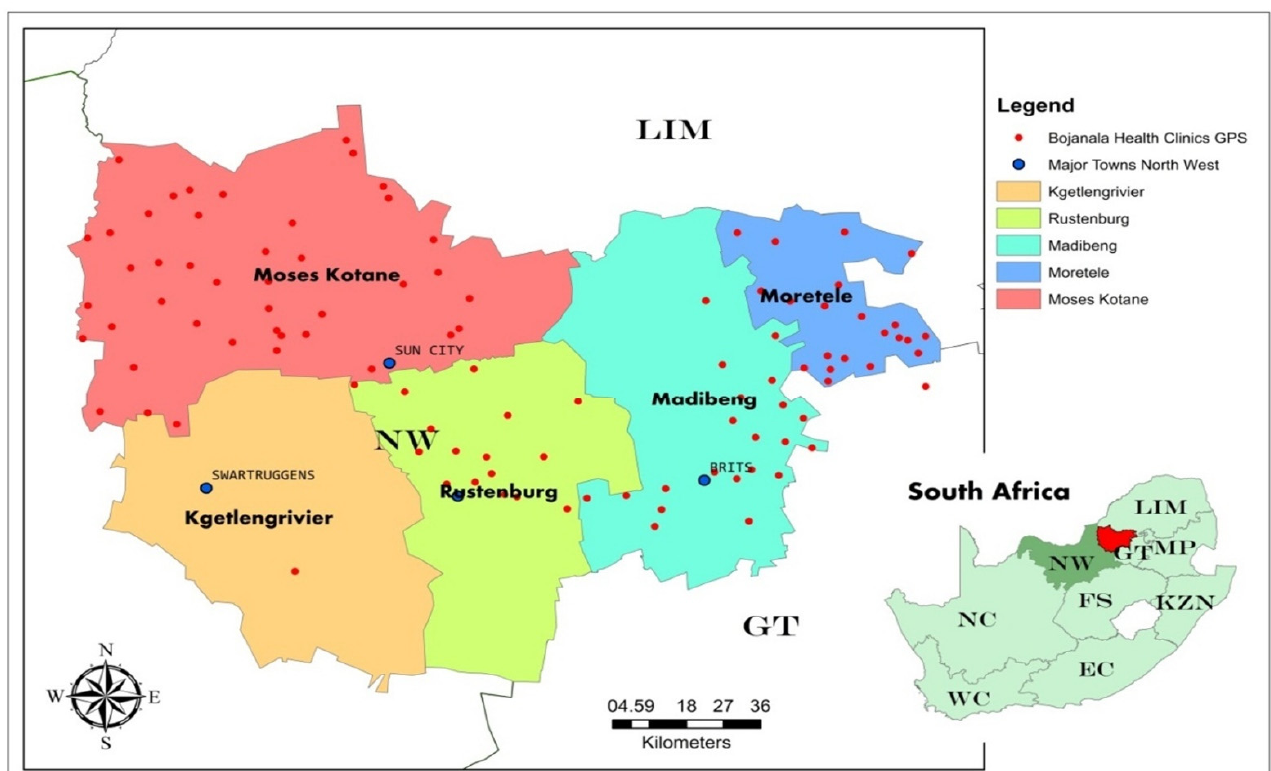
Figure 1. Locations of surveyed health clinic gardens in the local municipalities of the Bojanala District Municipality, North-West Province, South Africa.